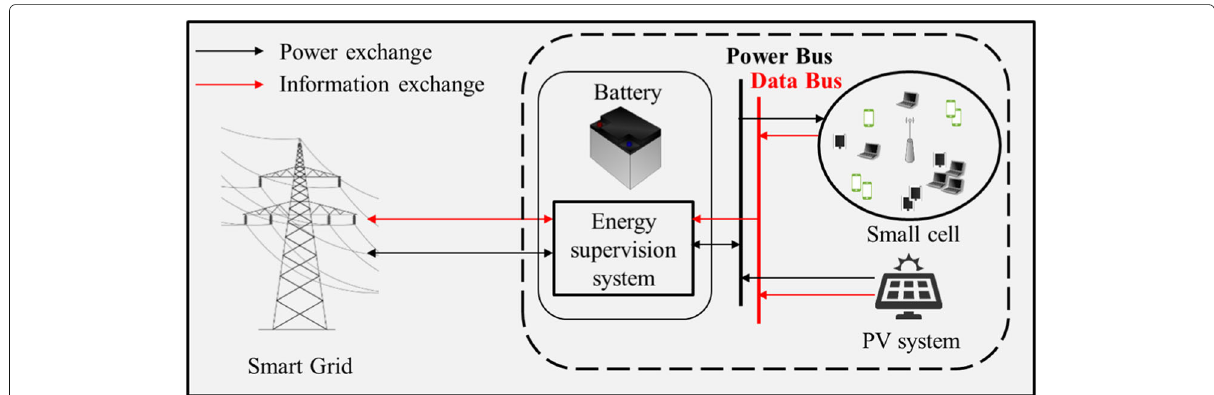
Fig. 1 System architecture of the proposed cognitive energy supervisor for small